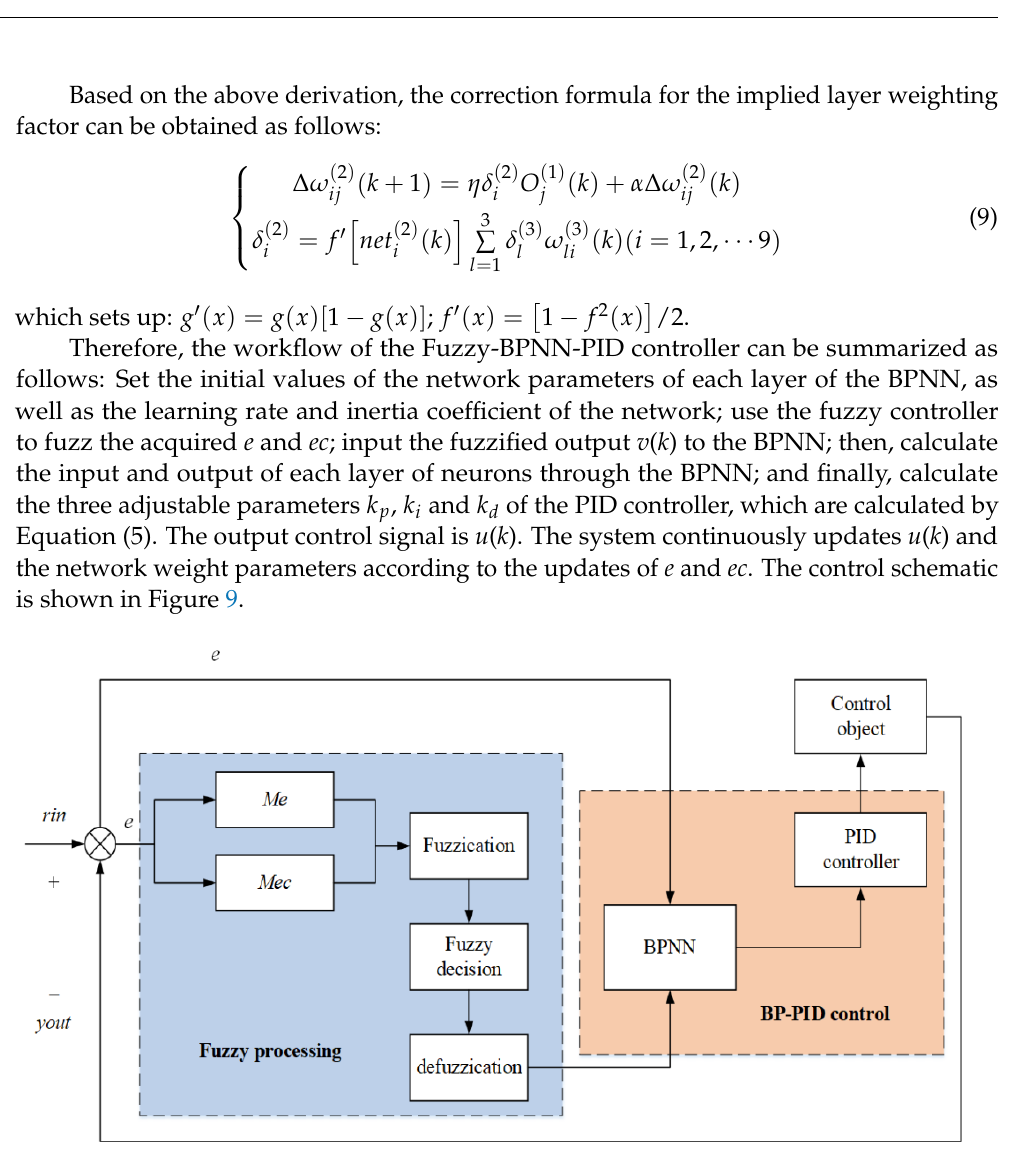
Figure 9. Fuzzy-BPNN-PID algorithm control